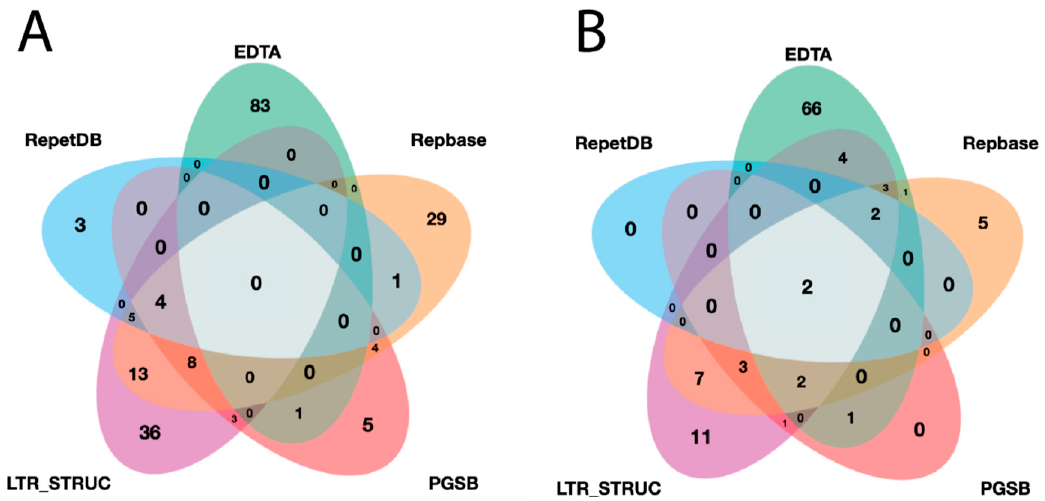
Figure 4. Venn diagrams representing: ( A ) the number of unique and shared plant species between datasets and ( B ) the number of unique and shared plant families between datasets.